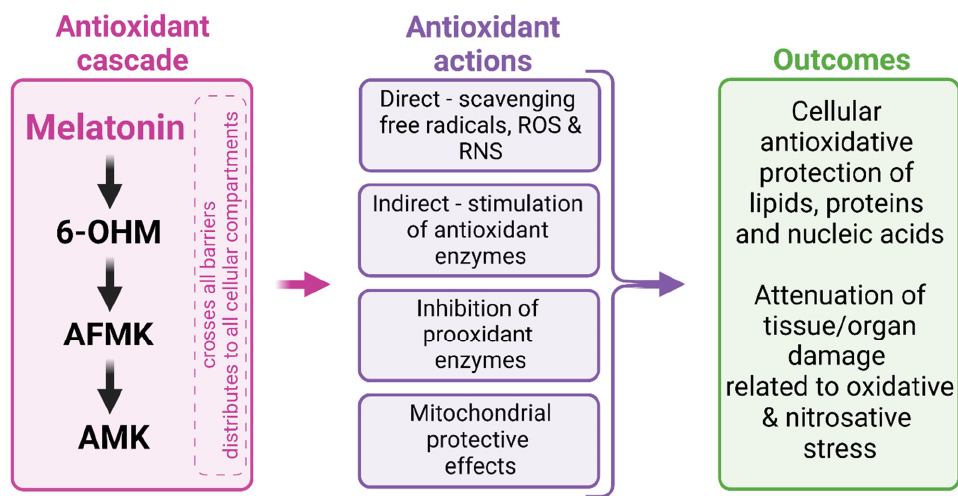
Figure 4. Mechanisms of melatonin’s antioxidant actions. 6-OHM, 6-hydroxymelatonin; AFMK, N1-acetyl-N2-formyl-5-methoxykynuramine; AMK, N1-acetyl-5-metoxykynuramine; RNS, reactive nitrogen species; ROS, reactive oxygen species.